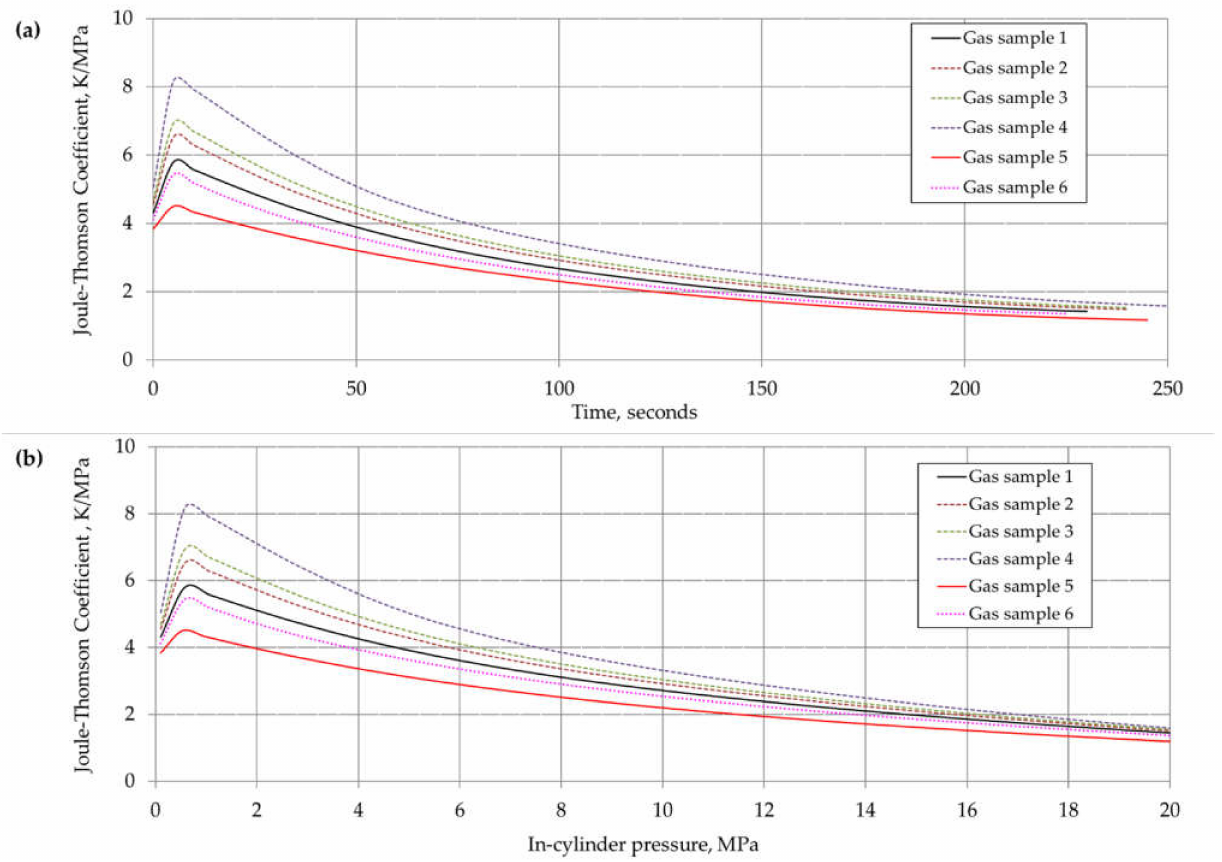
Figure 4. In-cylinder Joule–Thomson coefficient changes for the considered natural gas mixtures during the composite tank fast filling process: ( a ) vs. pressure change in the composite tank; ( b ) vs. filling time of the composite